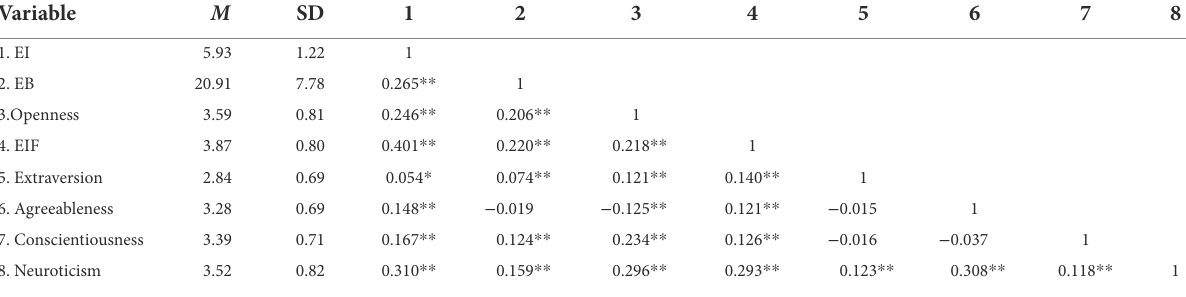
TABLE 3 Means, standard deviations, and correlations among variables. Variable